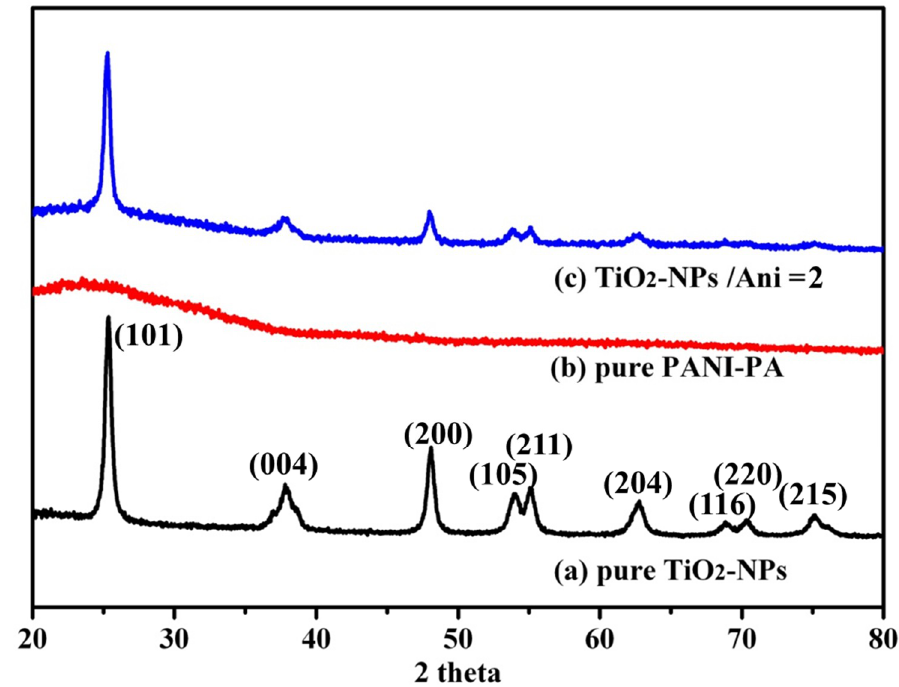
Figure 5. XRD pattern of ( a ) pure TiO 2 NPs; ( b ) the PANI films prepared by phosphoric acid and ( c ) TiO 2 @PANI sample produced at m (TiO 2 )/m (Ani) = 2.